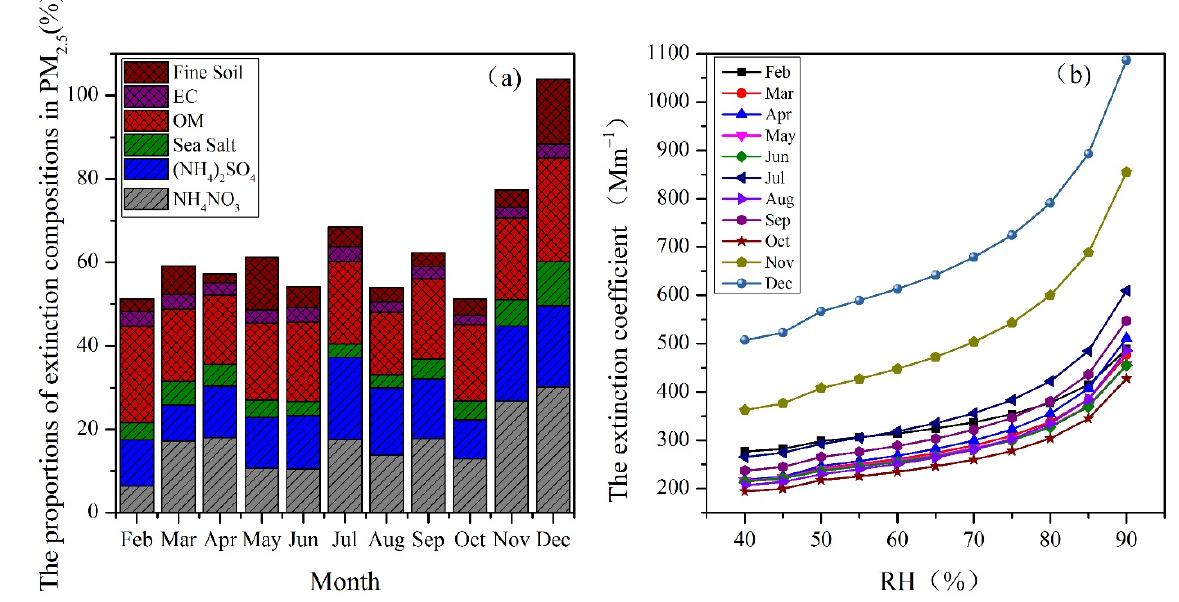
Figure 6. Monthly average proportions of major extinction compositions in PM 2.5 ( a ) and the variation of extinction coefficient with increased RH under different aerosol types, taking chemical compositions of PM 2.5 in different months for examples ( b ); chemical composition of PM 2.5 was the monthly mean proportions of extinction components in PM 2.5 in Tianjin, 2015; PM 2.5 concentration was set to 100 µg/m 3 ; the extinction coefficient was calculated by IMPROVE equation.